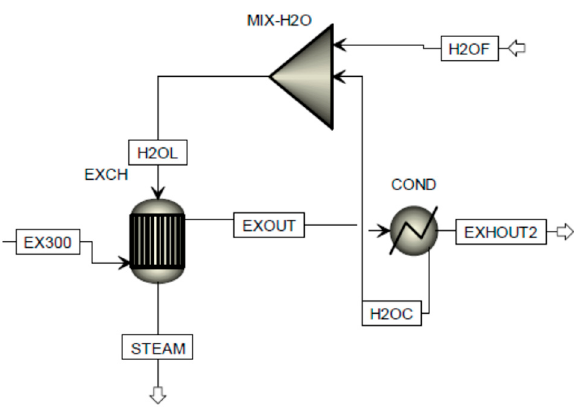
Figure 3. Steam generator system flowsheet. Table 3. Description of Aspen Plus unit operation blocks and streams of the flowsheet presented in Figure